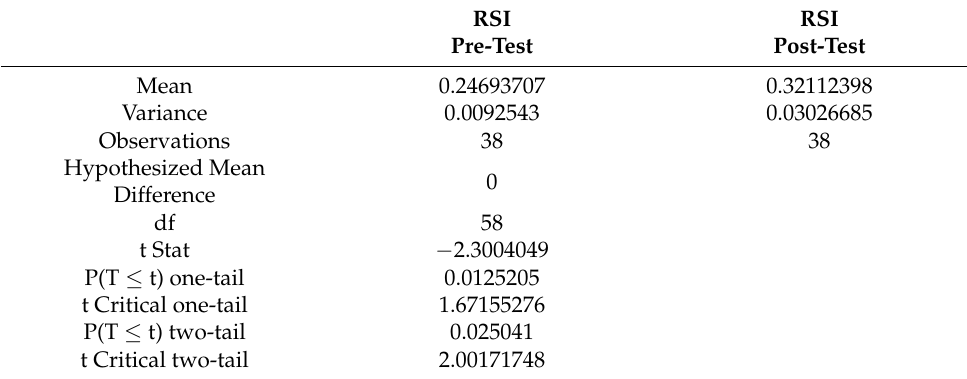
Table 5. Welch’s t -test: Two-sample assuming unequal